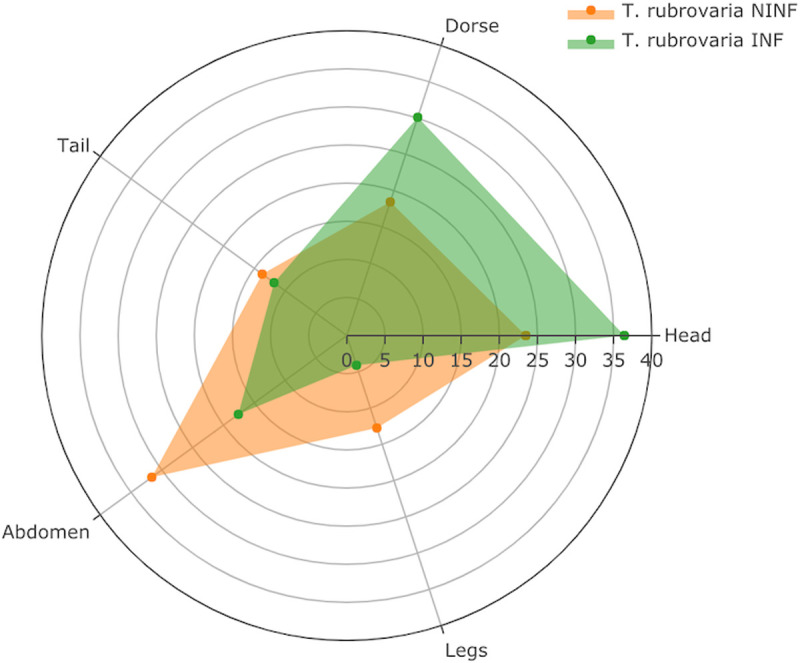
Radar chart exhibiting the percentage of bites of non-infected (NINF) and infected (INF) T. rubrovaria on different parts of mice’s body (head, dorse, tail, abdomen and legs).